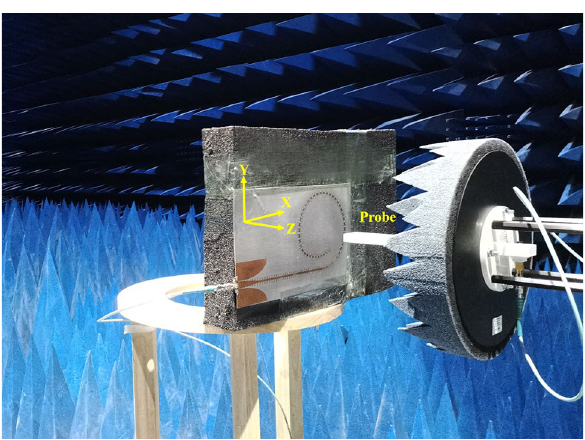
Figure 4. Experimental platform in an anechoic chamber for antenna performance